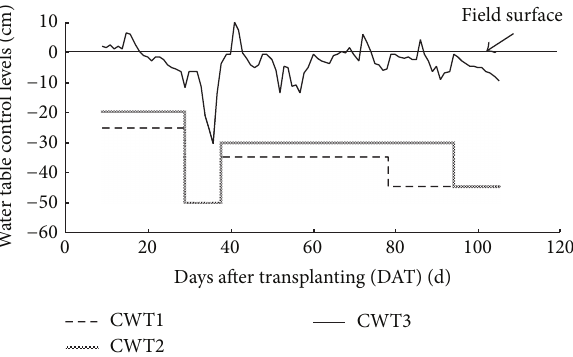
Figure 1: Water table control levels for CWT1, CWT2, and